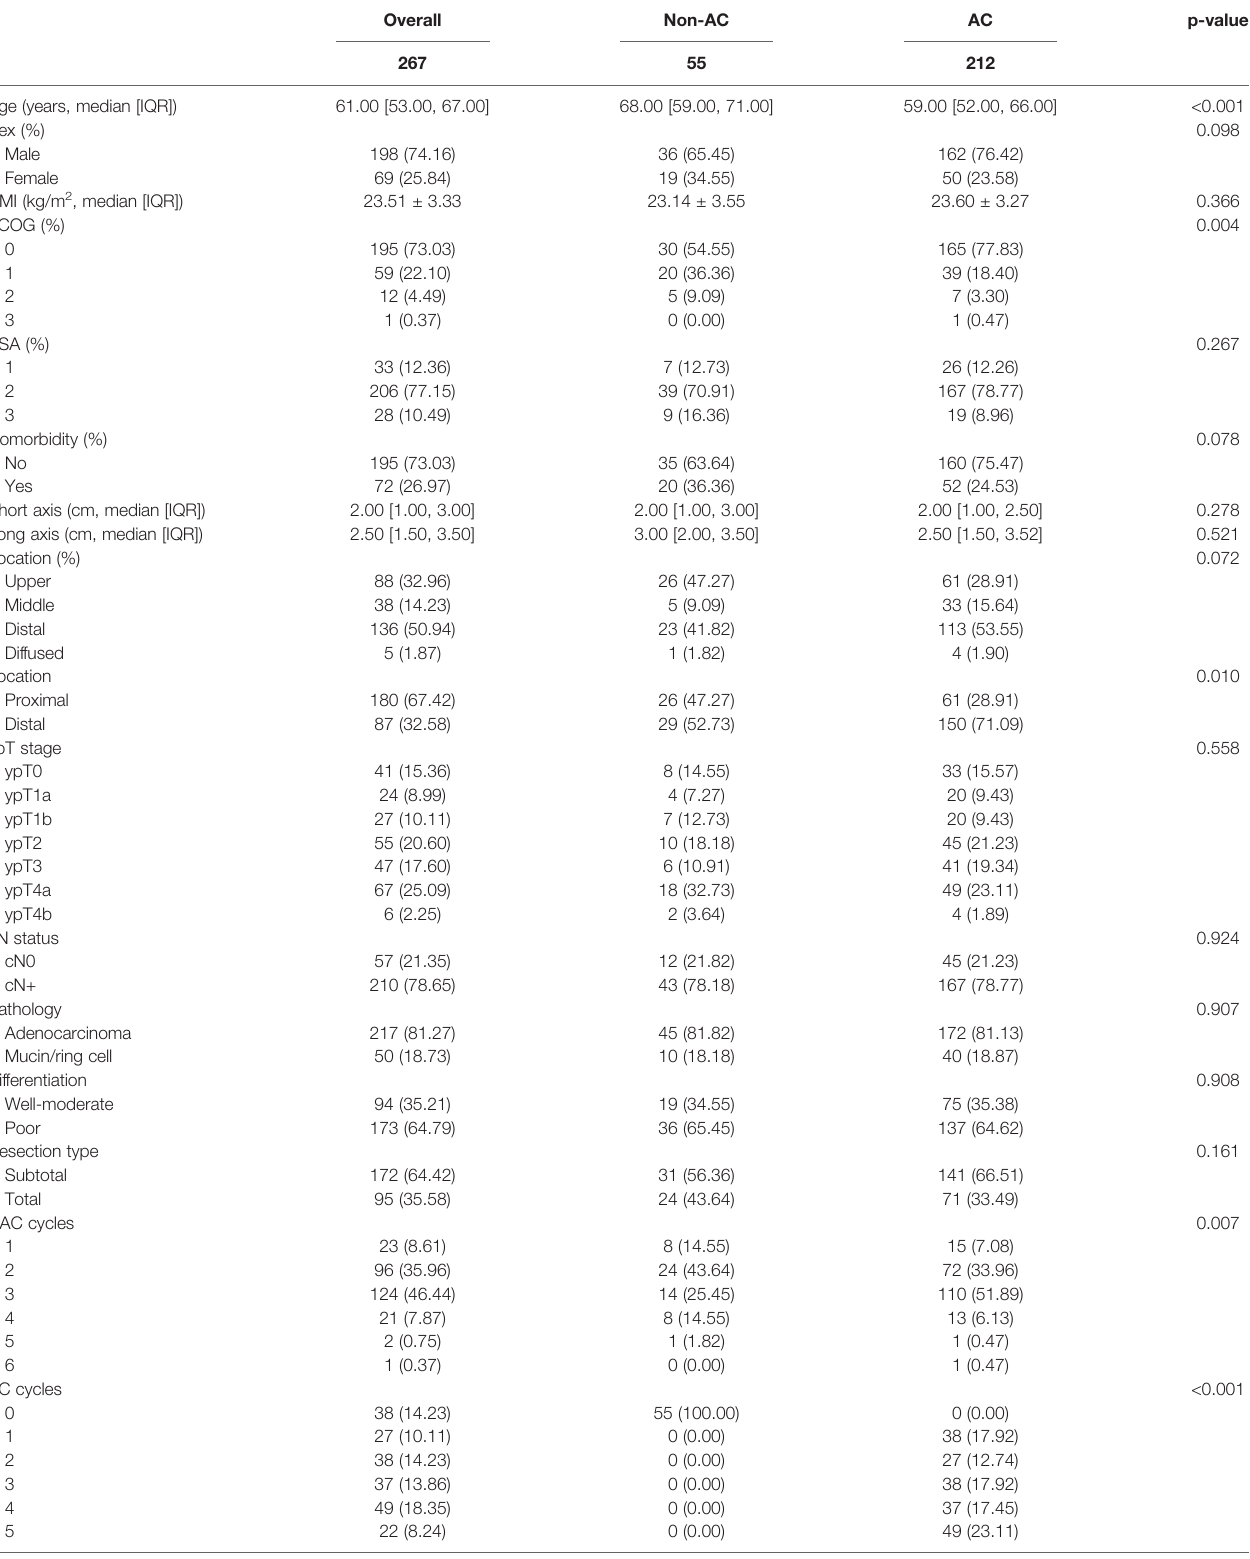
TABLE 2 | Demographic and clinicopathological characteristics in non-AC and AC groups. N